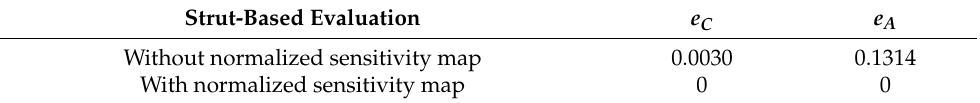
Table 2. Reconstructed value errors of single-defect reconstructions in simulation.